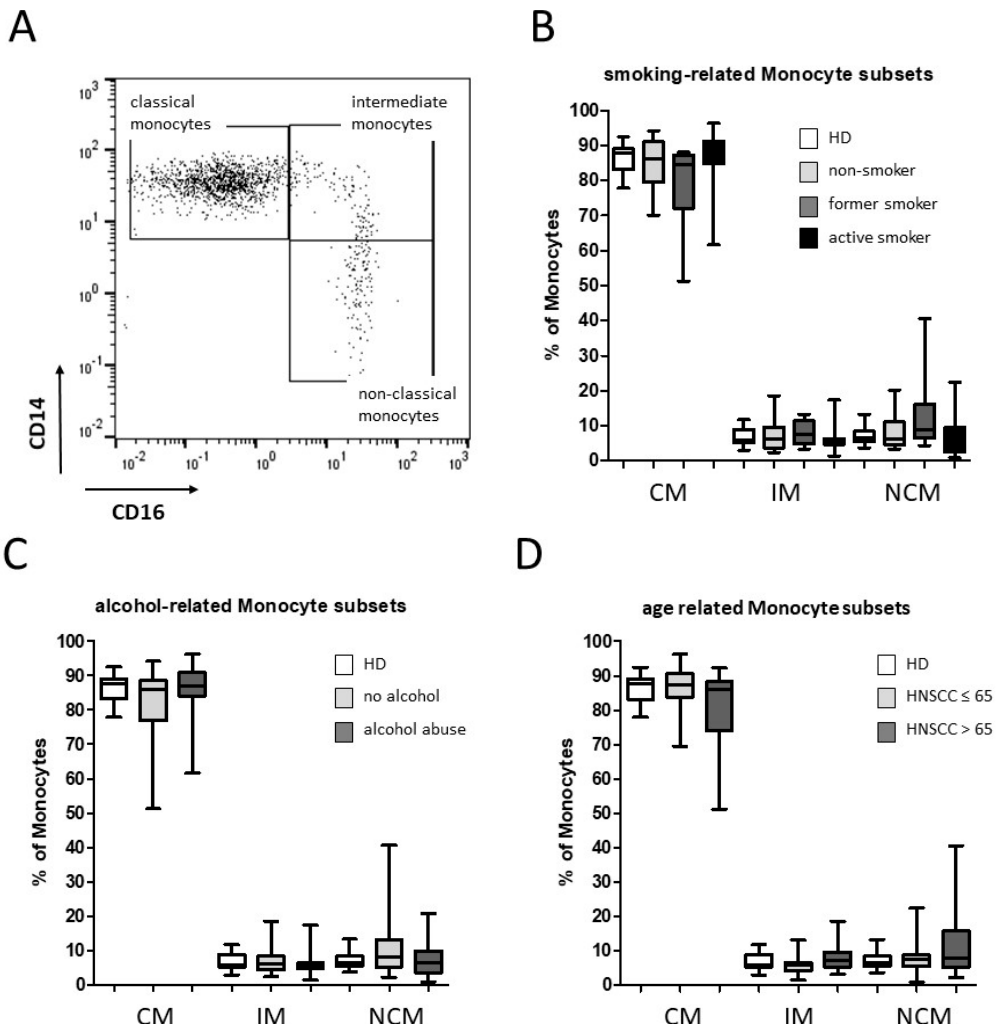
Figure 1. Flow cytometric analysis of CD14 and CD16 characterized monocyte subsets. ( A ) Representative example gating scheme of peripheral monocyte subset analysis by flow cytometry. ( B ) Whole blood analysis revealed similar median abundances of classical monocytes (CM), intermediate (IM), and non-classical monocytes (NCM) in non-smoking, former-smoking, and active-smoking HNSCC patients as well as in alcohol associated HNSCC patients ( C ) and age-related individuals ( D ) compared to healthy donors, but stronger dispersions of monocyte subset distributions in cancer patients.